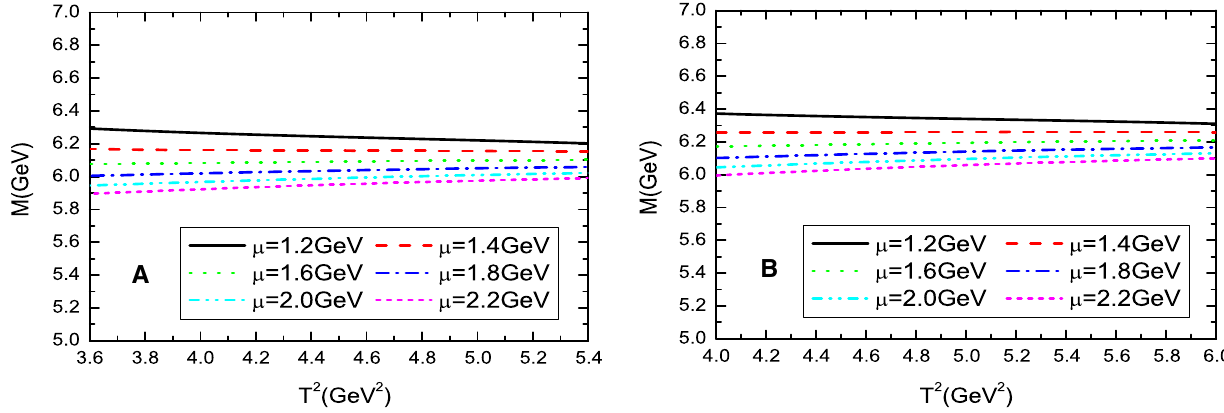
Fig. 1 The masses of the cc ¯ c ¯ c tetraquark states with variations of the energy scales and Borel parameters, where the A and B denote the cc ¯ c ¯ c ( 0 ++ ) and cc ¯ c ¯ c ( 2 ++ ) , respectively